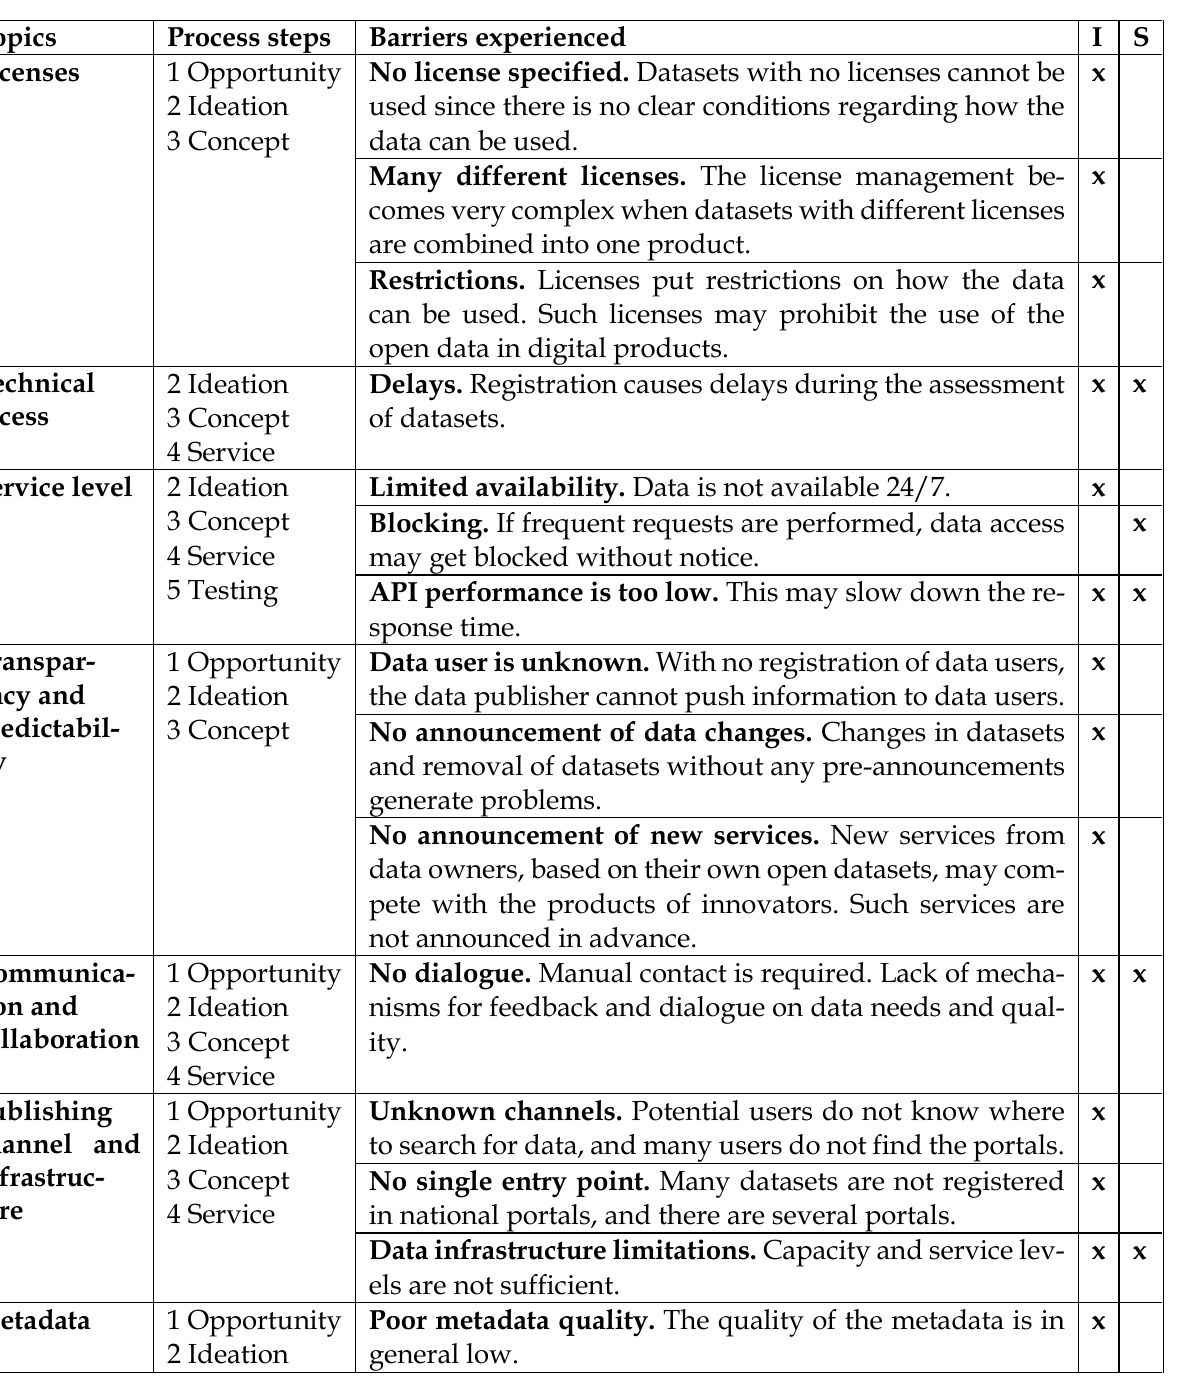
Table 4 Barriers experienced in digital product innovation with open data and affected